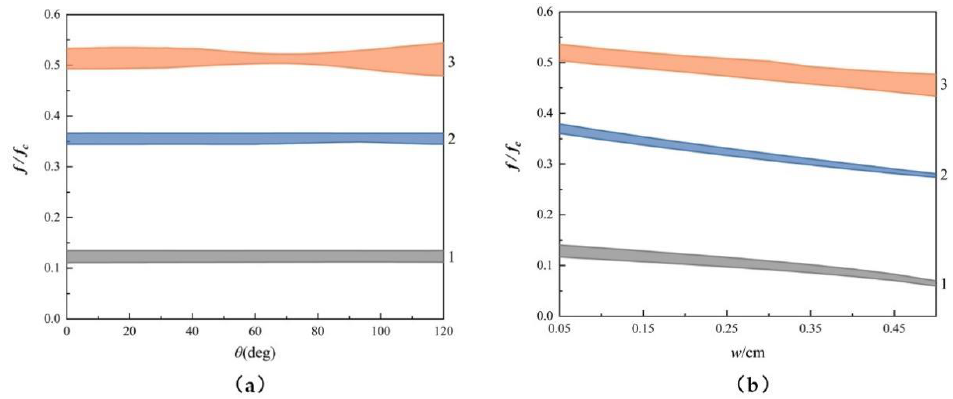
Figure 3. The first, second and third band gap varies with geometric parameters marked by grey, blue, and orange areas, respectively. ( a ) Rotation angle θ ranging from 0°to 120°. ( b ) Width of spiral w ranging from 0.05 cm to 0.5 cm.